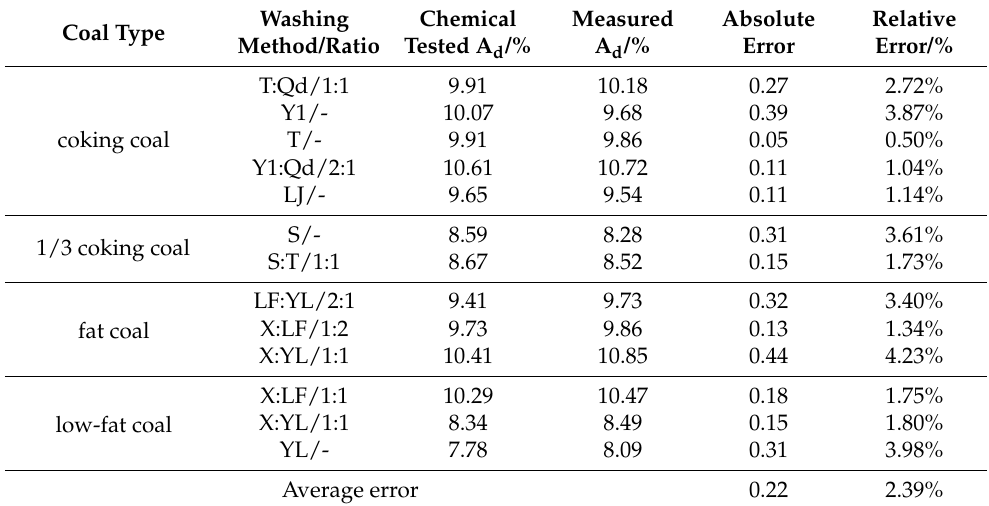
Table 13. Average ash content per day in May for coal in the western part of the Linhuan Coal Preparation